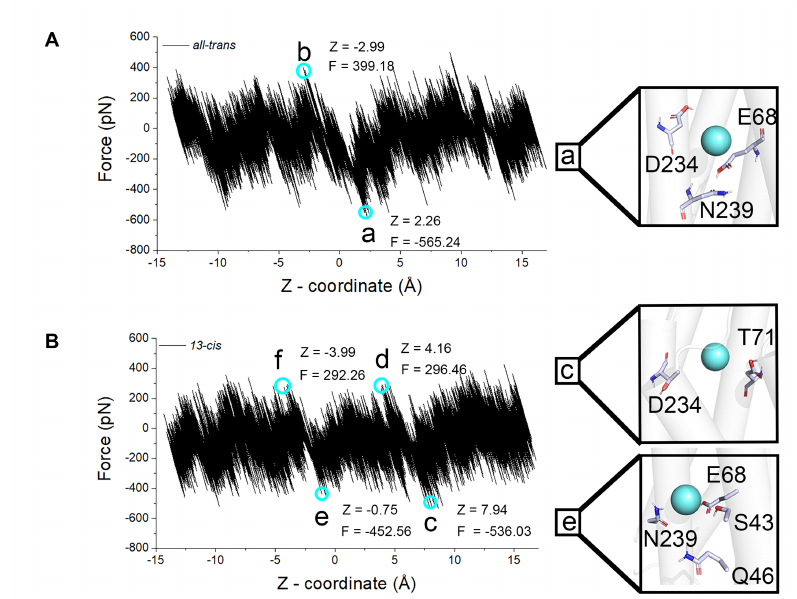
Figure 4. Traction path of chloride ions in SMD simulations. The path that chloride ions are stretched at a constant speed in ( A ) E68p-D234p( trans ) and in ( B ) E68p-D234p( cis ). a–f means the positions that have maximum/minimum force when the Cl − was pulled.